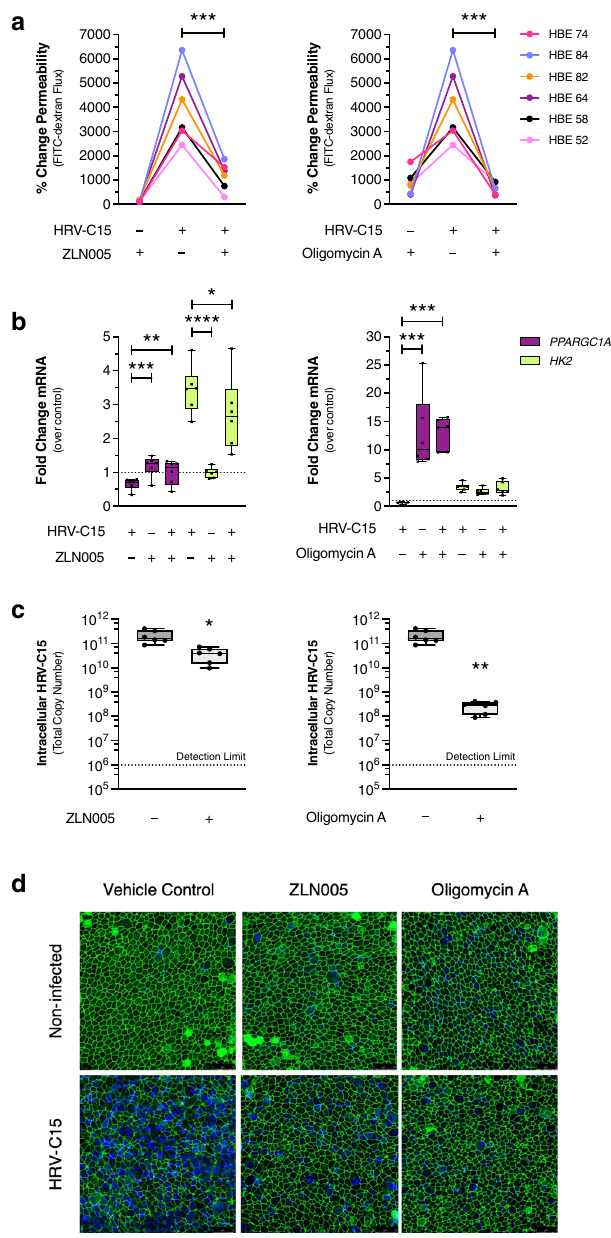
expression in the same rank order of effect as they modulate barrier function supports the concept that this pathway may be of general importance for multiple HRV strains. Antiviral therapies typically aim to inhibit viral binding or suppress viral replication, ultimately reducing viral titers. How- ever, levels of viral shedding alone may not adequately re fl ect effects on airway cell function. For example, Gualdoni et al.